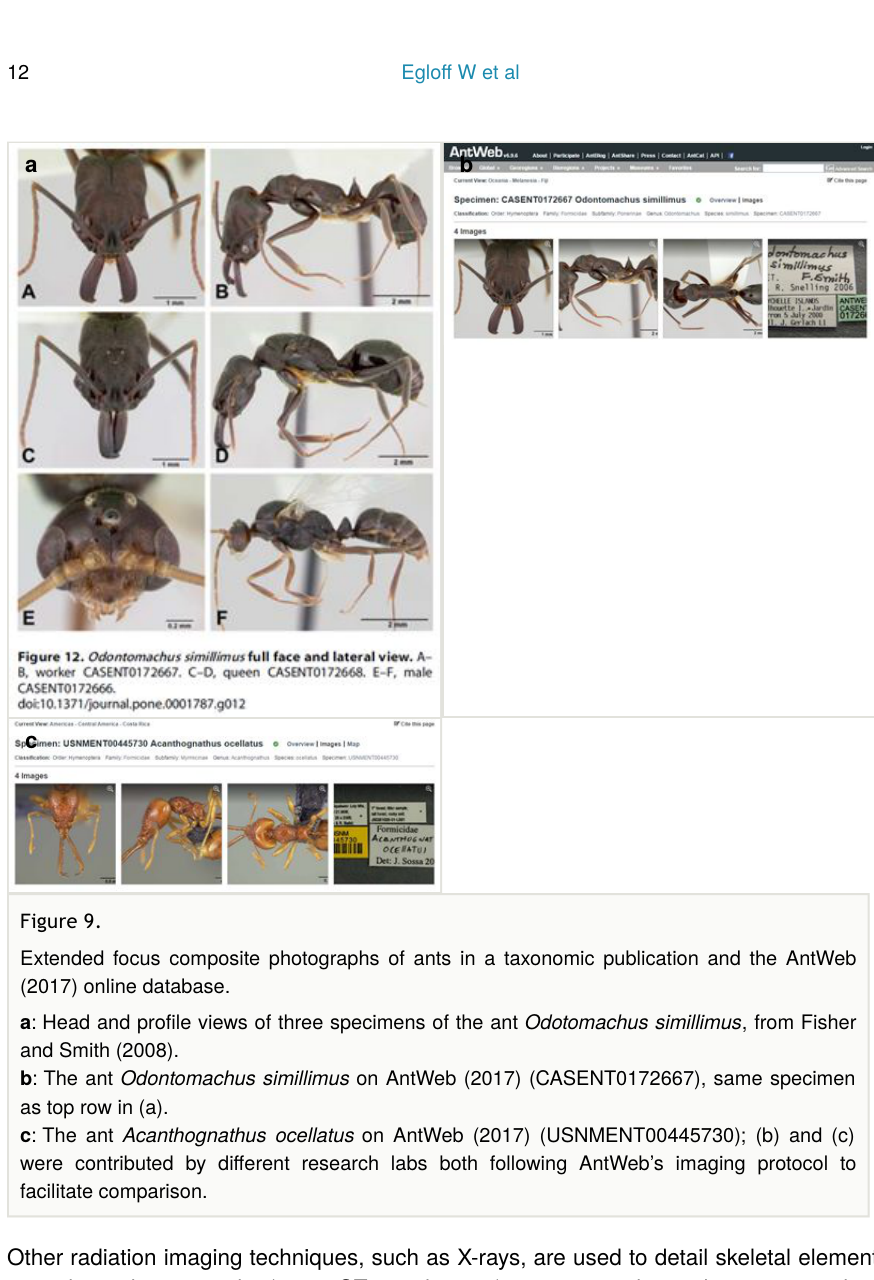
Other radiation imaging techniques, such as X-rays, are used to detail skeletal elements in animals, and tomography (micro-CT, synchrotron) is increasingly used to compare detailed anatomy with the aid of three dimensional computer models (Fig. 10); Faulwetter et al. 2013). With three dimensional interactivity, structures can be compared from any angle. Sonograms are used to represent and compare the sounds made by organisms such as birds, crickets, bats, and whales (Fig. 11).